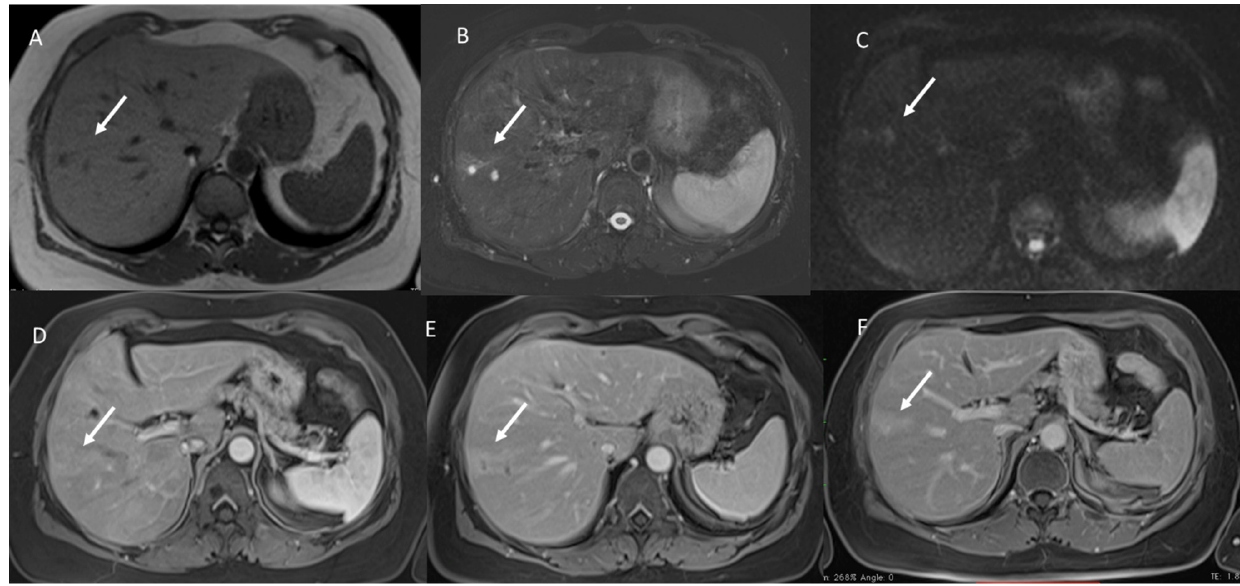
Figure 3. Mucinous liver metastasis (arrow) on VII-VIII hepatic segment. In ( A ) T1-W image, the lesion shows hypointense signals. In ( B ), the lesion shows very high SI in T2-W and restricted diffusion in b800 s/mm 2 ( C ). During contrast study (( D ) arterial phase, ( E ) portal phase and ( F ) equilibrium phase), the lesion shows progressive enhancement from arterial to delayed phase on contrast study.